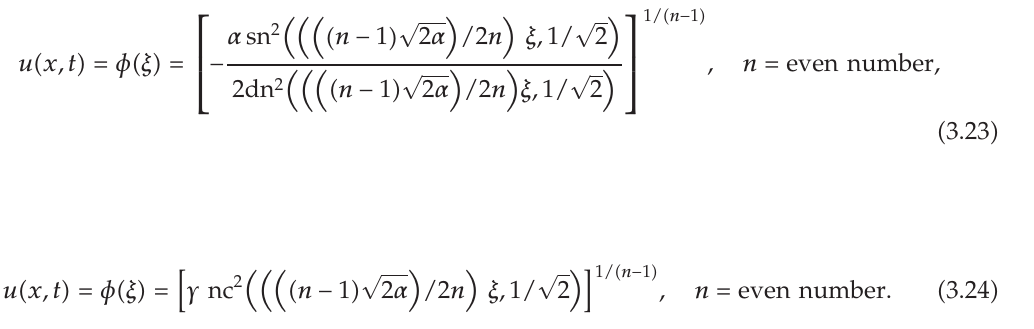
u (cid:2) x, t (cid:3) (cid:8) φ (cid:2) ξ (cid:3)